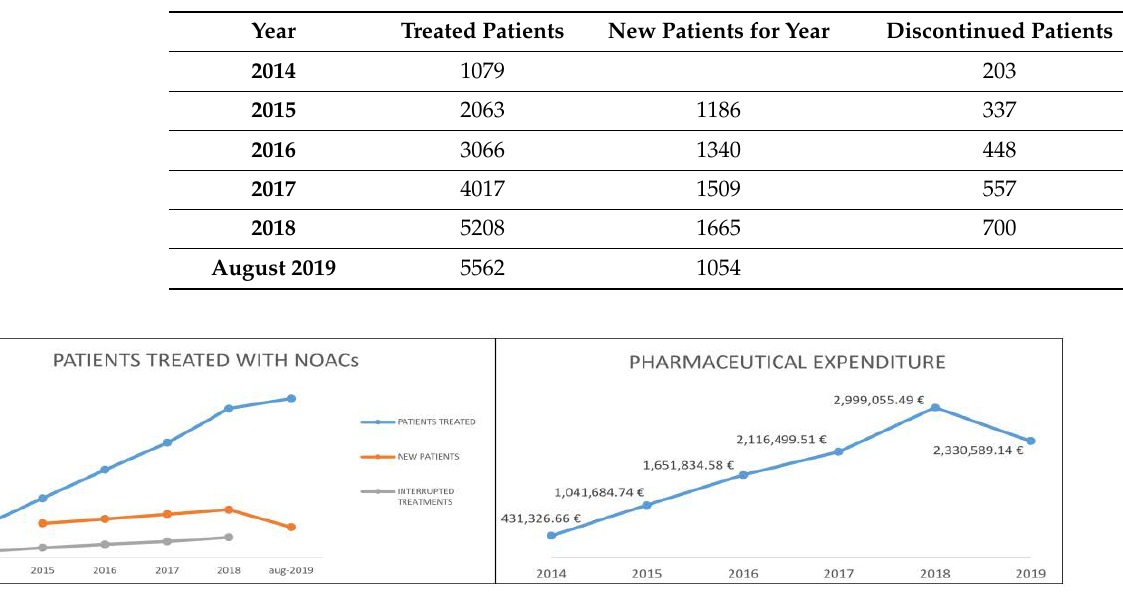
Figure 1. Patients treated in LHA BT and pharmaceutical expenditure